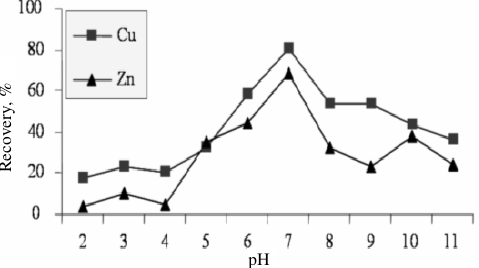
Figure 1. The effect of pH on the recovery of metal ions.